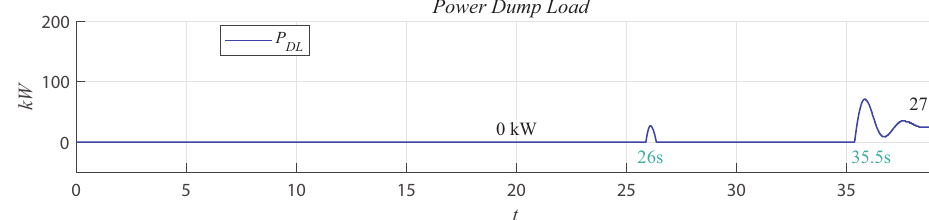
Figure 18. Power in the DL for case study 2.